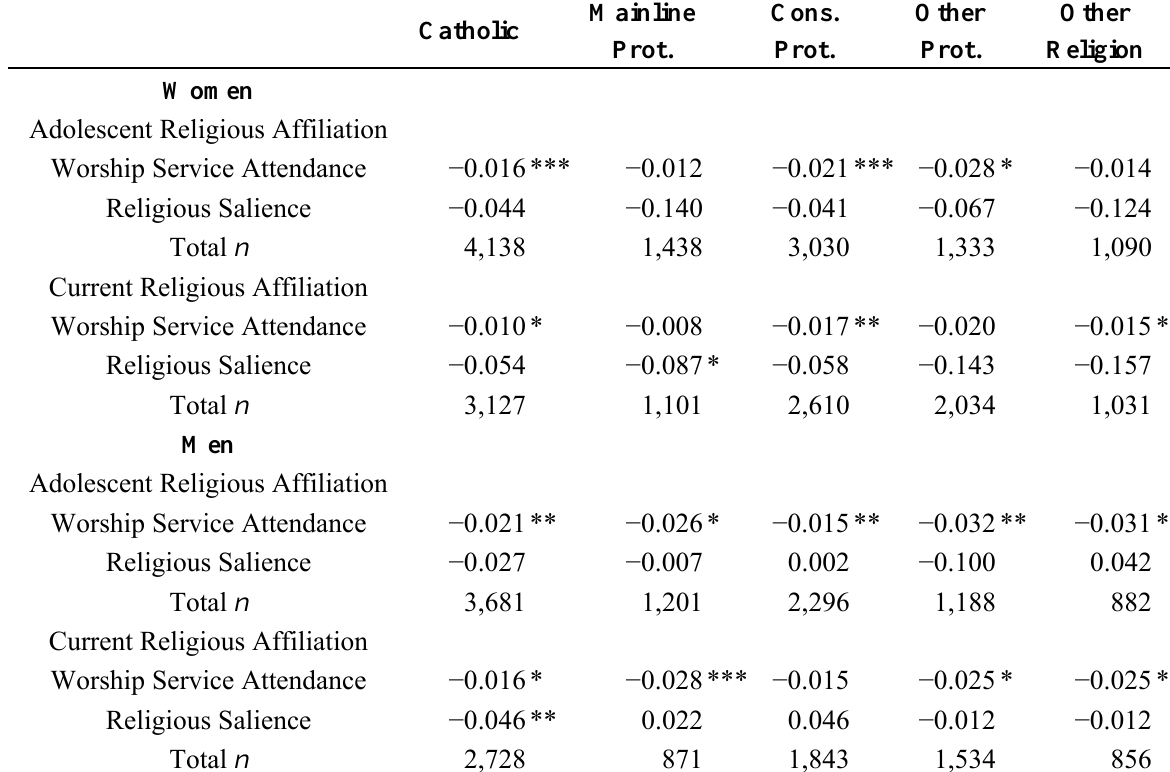
Table 4. Maximum Likelihood Parameter Estimates from Log-Logistic Survival (AFT) Regressions of Waiting Time on Religious Variables By Denomination and Gender.